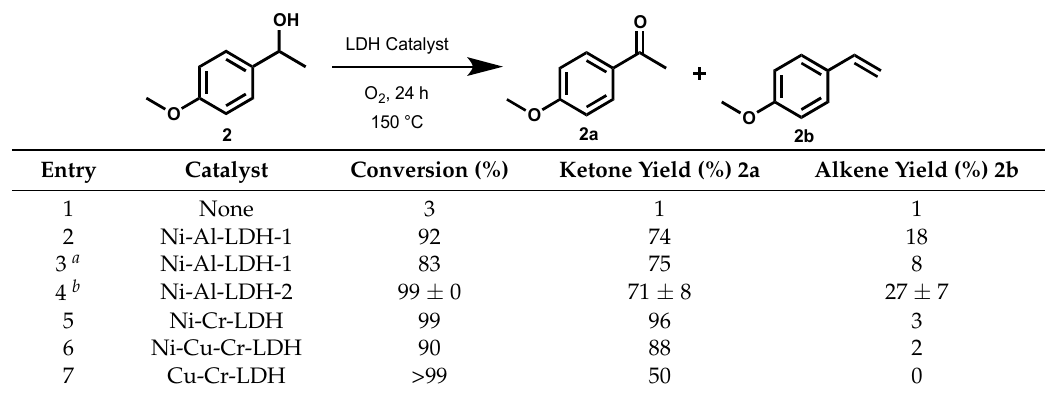
Table 5. Conversion of 2 over various LDH catalysts in phenyl ether with O 2 .